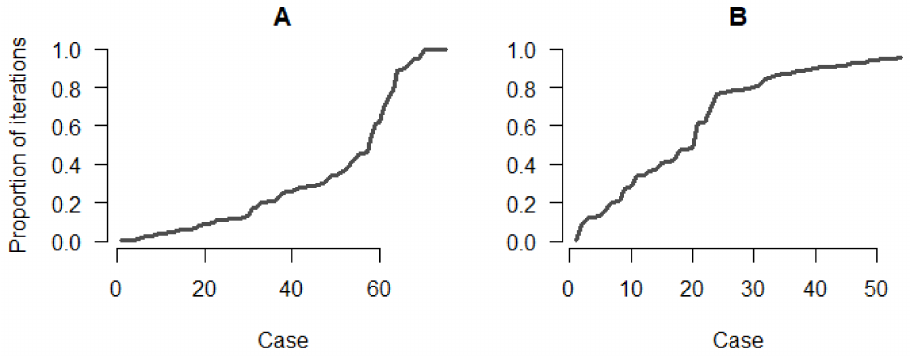
Figure 8. Panel A : Proportion of iterations with the correct index for each case; Panel B : Proportion of iterations where the index is from the correct